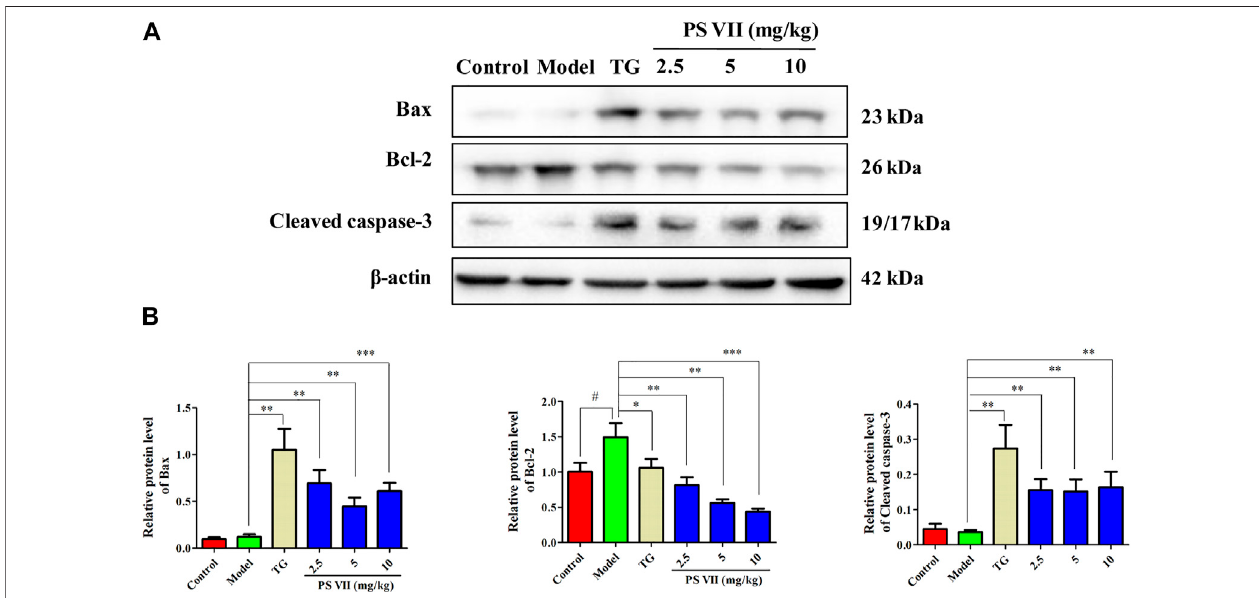
FIGURE 12 | Effects of PS VII on proteins in the synovial tissues of experimental rats. (A) The expression of Bax, Bcl-2, Cleaved caspase-3 in synovial tissues was determinedbywesternblotanalysis. (B) Relativeproteinexpressionwasdeterminedbyopticaldensityanalysis.ImageJwasusedtodeterminethedensityratioofeach protein band relative to β -actin band. Data were expressed as mean ± SD, n (cid:2) 5. Compared with the control group, # p < 0.05, ## p < 0.01, compared with the model group, * p < 0.05, ** p < 0.01, *** p < 0.001.